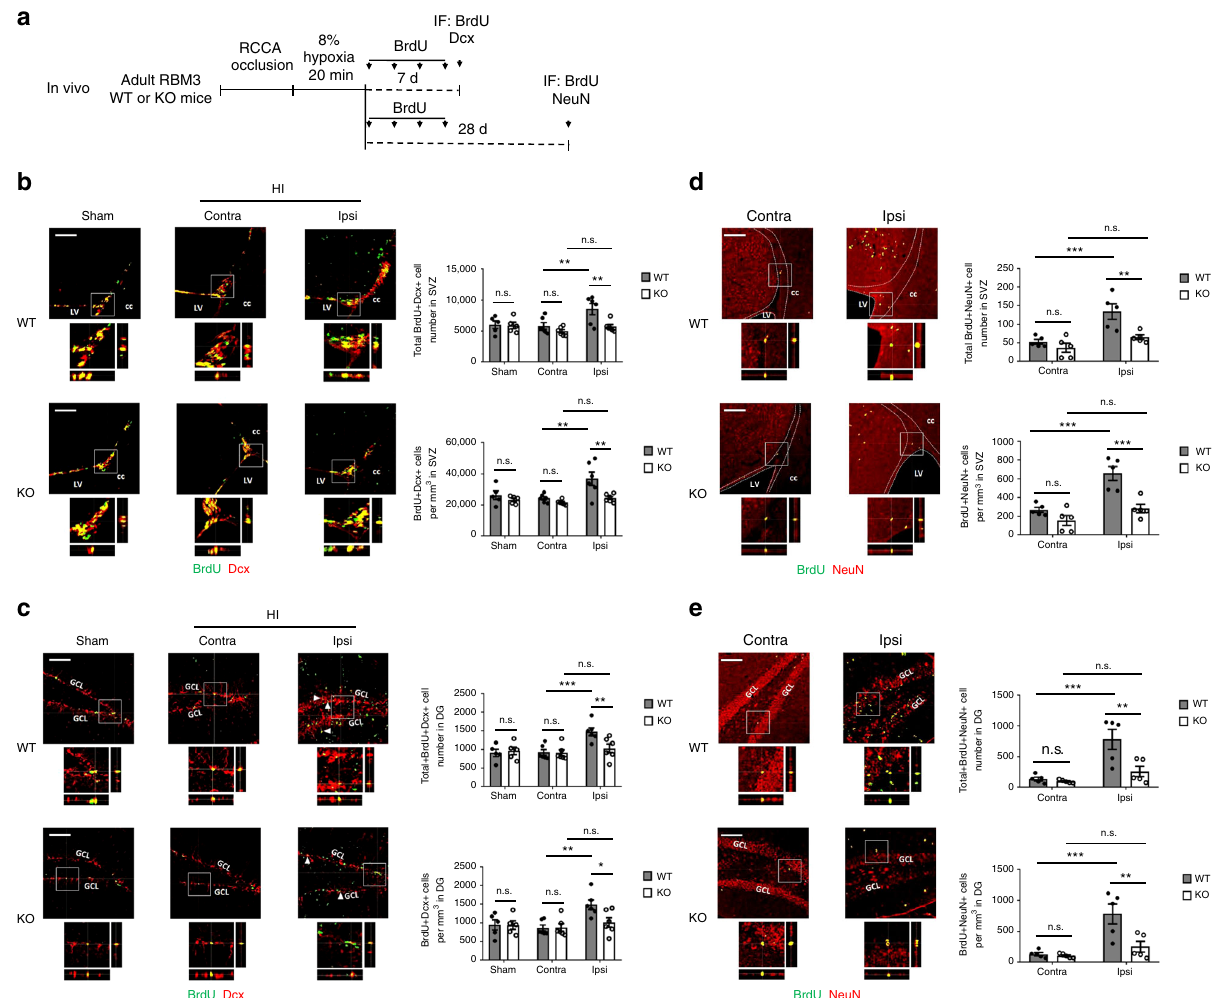
Fig. 2 RBM3 promotes neurogenesis in both SVZ and SGZ after HI injury in vivo. a Illustration of in vivo HI model and analysis of neurogenesis. RCCA right common carotid artery, IF immuno fl uorescence. b , c Representative immuno fl uorescent staining of BrdU and Dcx in SVZ ( b ) or DG ( c ) of RBM3 WT and KO animals treated with HI and recovered for 7 days with BrdU injection every other day. Animals in control group received sham surgery. Orthogonal view con fi rmed the co-localization of BrdU and Dcx. BrdU + Dcx + cell number and density in the SVZ or DG were estimated. Five sham animals and six HI animals were counted per group (Sham: n = 5, HI: n = 6). Sham, sham group; contra, contralateral (uninjured side) in HI group; ipsi, ipsilateral (injured side) in HI group. Scale bar: 100 µ m. LV lateral ventricle, cc corpus callosum, GCL granular cell layer. Repeated measures two-way ANOVA was used for statistical analysis; n.s. not signi fi cant; * p < 0.05; ** p < 0.01; *** p < 0.001. d , e Representative immuno fl uorescent staining of BrdU and NeuN in SVZ ( d ) or DG ( e ) of RBM3 WT and KO animals treated with HI and recovered for 28 days with BrdU injection every 2 days in the fi rst week of recovery. Orthogonal view con fi rmed the colocalization of BrdU and NeuN. BrdU + NeuN + cell number and density in the SVZ or DG were estimated. Five animals were counted per group ( n = 5). Contra, contralateral (uninjured side); ipsi, ipsilateral (injured side). Scale bar: 100 µ m. LV lateral ventricle, cc corpus callosum, GCL granular cell layer. Repeated measures two-way ANOVA was used for statistical analysis; n.s. not signi fi cant; ** p < 0.01; *** p < 0.001. All data are presented as mean ±